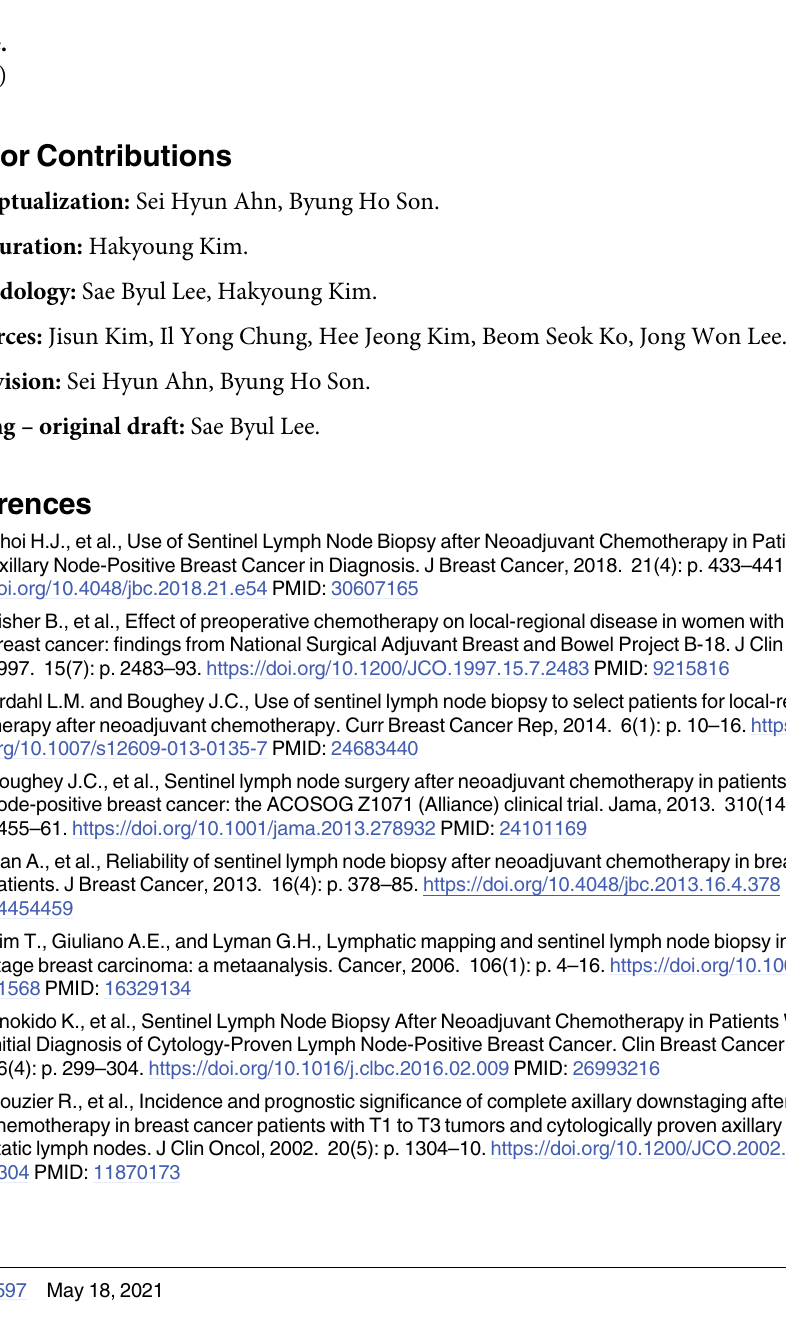
S1 Fig. Kaplan–Meier curves according to pathological node status. Axillary recurrence- free survival (a), locoregional recurrence-free survival (b), distant metastasis-free survival (c), and overall survival (d). S2 Fig. Kaplan–Meier curves according to clinical node status. Axillary recurrence-free sur- vival (a), locoregional recurrence-free survival (b), distant metastasis-free survival (c), and overall survival